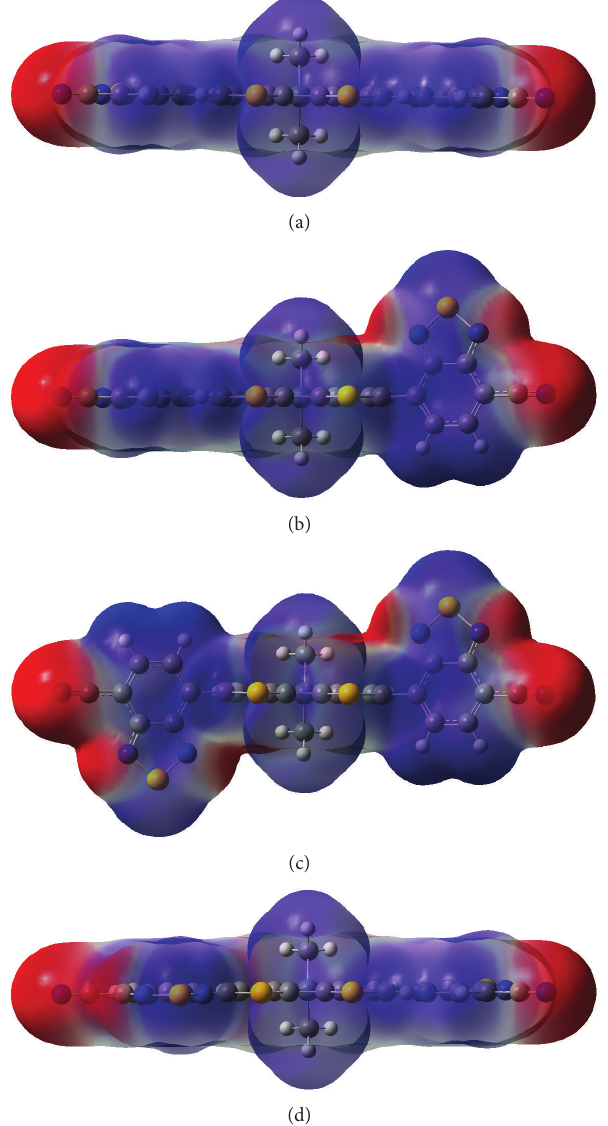
Figure 3: MEP surfaces of the BCNDTS molecule at (a) 𝛼 = 𝛽 = 0 ∘ , (b) 𝛼 = 0 , 𝛽 = 90 ∘ , (c) 𝛼 = 90 ∘ , 𝛽 = 90 ∘ , and (d) 𝛼 = 180 ∘ , 𝛽 = 0 ∘ .